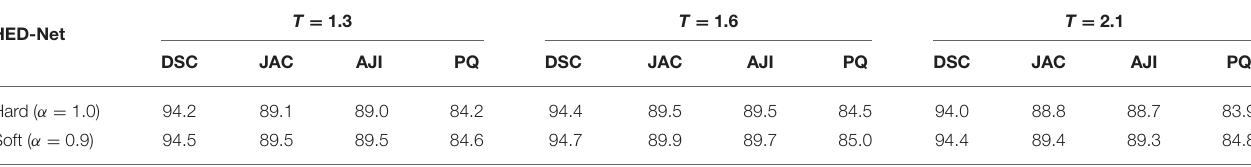
TABLE 7 | The impact of choosing different thresholds T for the ovality p . T = 1.3 T = 1.6 T = 2.1 HED-Net DSC JAC AJI PQ DSC JAC AJI PQ DSC JAC AJI PQ Hard ( α = 1.0) 94.2 89.1 89.0 84.2 Soft ( α = 0.9)